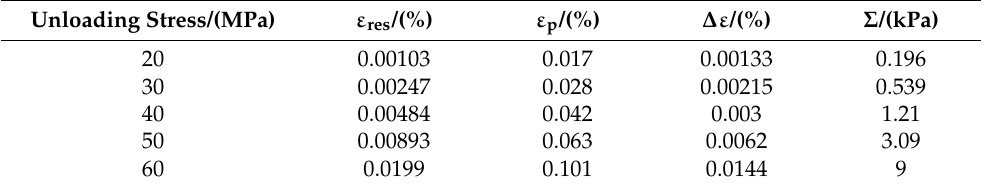
Table 5. Cyclic loading/unloading damage parameters of Type 3 3D needle-punched C/SiC